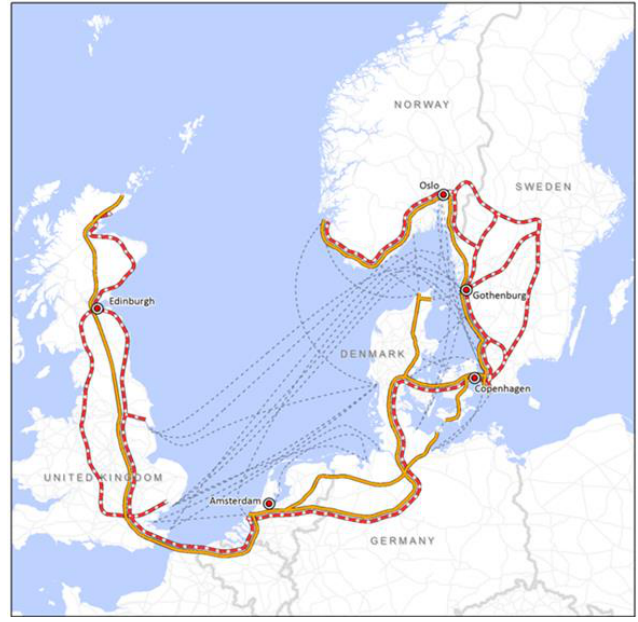
Figure 3. GreCOR corridor